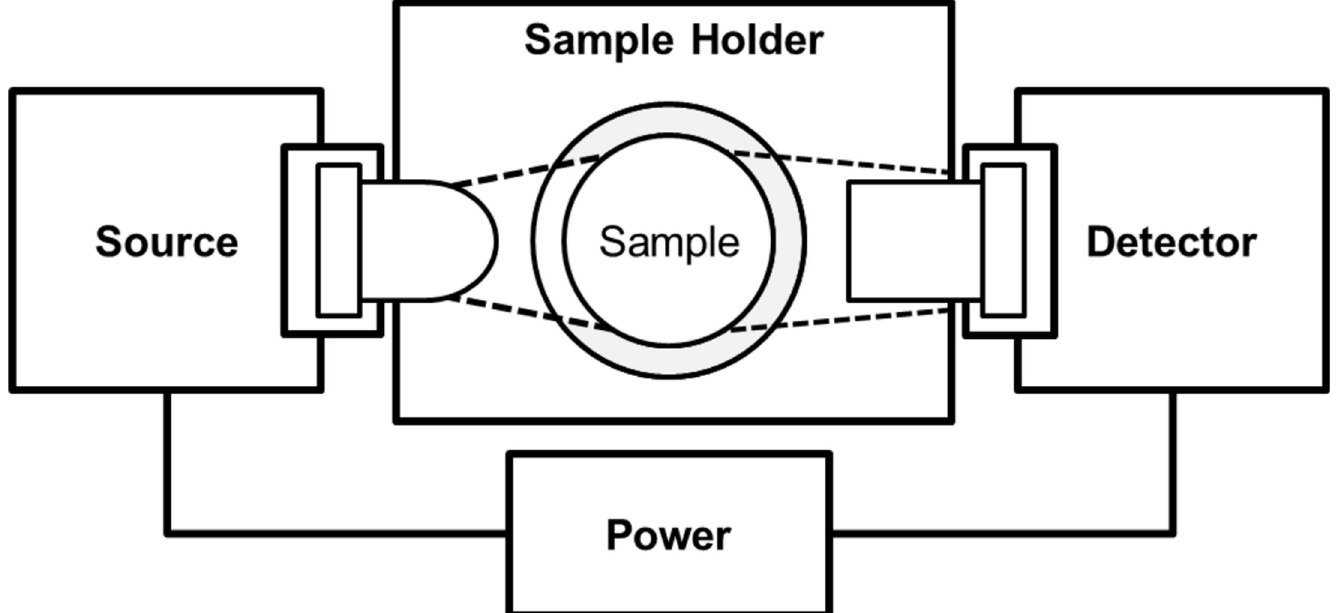
Fig 2. A block diagram of the light emitting diode (LED) spectrophotometer.